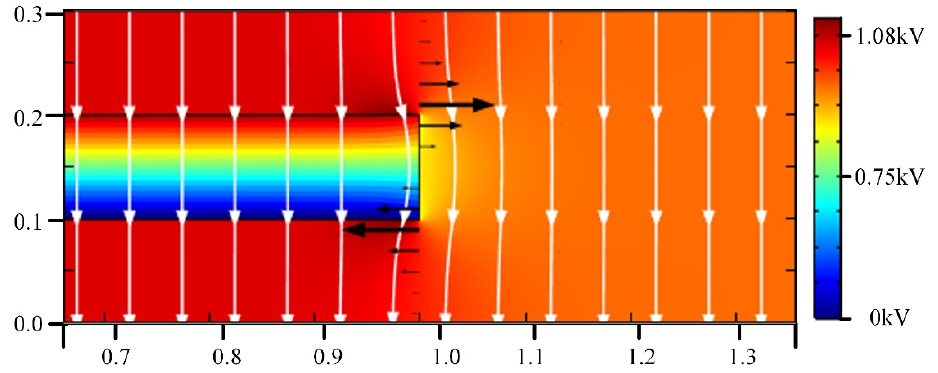
Figure 6. Distribution of electric field and potential at peak discharge moment.